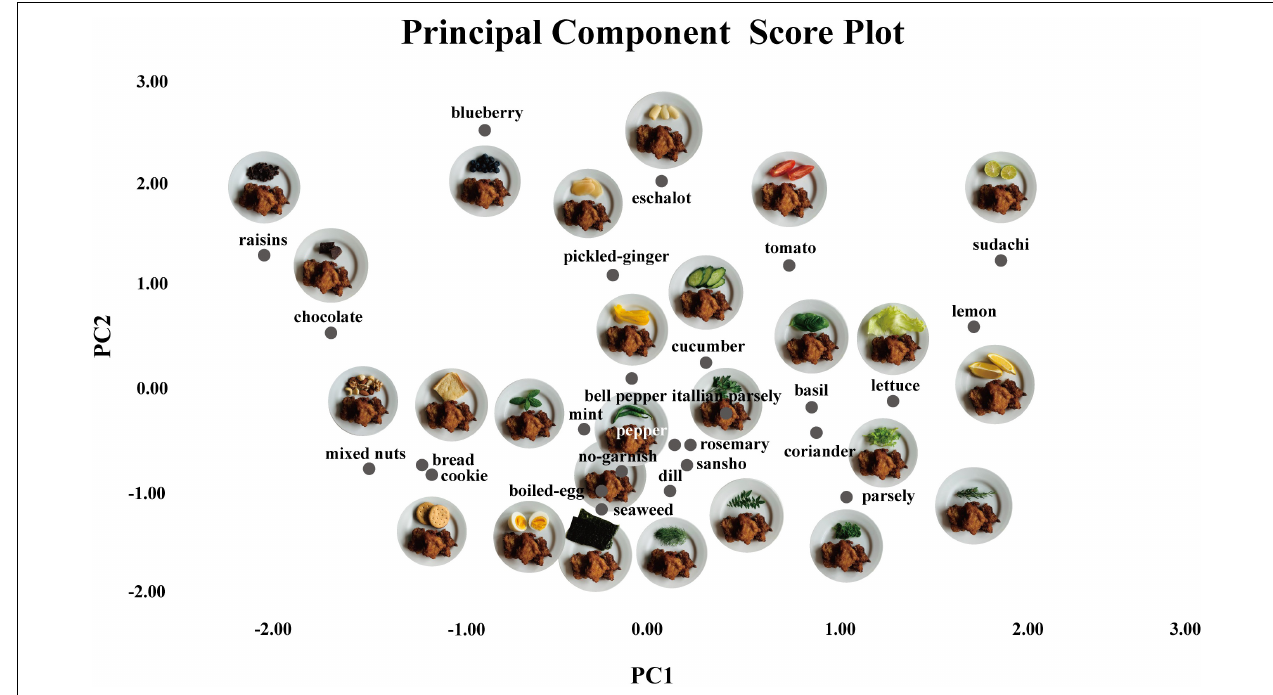
FIGURE 3 | We created a scatter plot based on the principal component scores and superimposed the images of the main dish and the garnish on a two-dimensional plane to visualize the relationship between the main dish and the garnish. Similar-colored garnishes were located close together in this plot. The results of the sensory evaluation showed that sudachi (citrus fruit) was the most suitable garnish to balance the taste of the main dish.